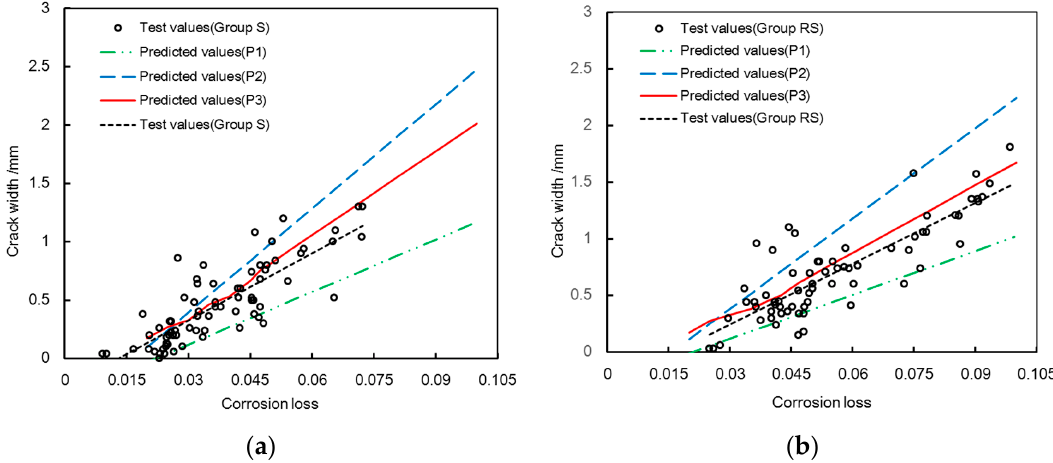
Figure 17. Predicted crack widths under the various rust-filling ratios: ( a ) Group S; and ( b ) Group RS.